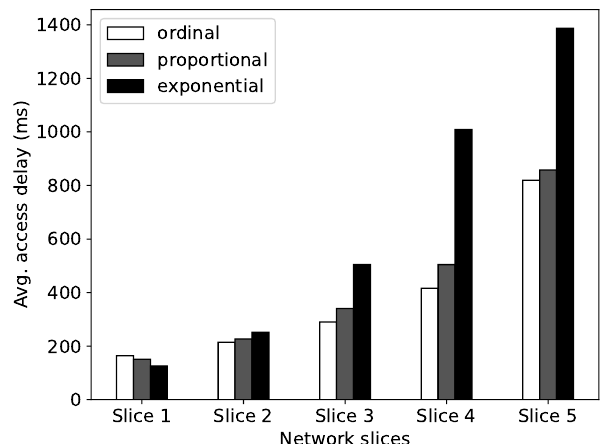
Figure 7. The effect of priority factors on the average access